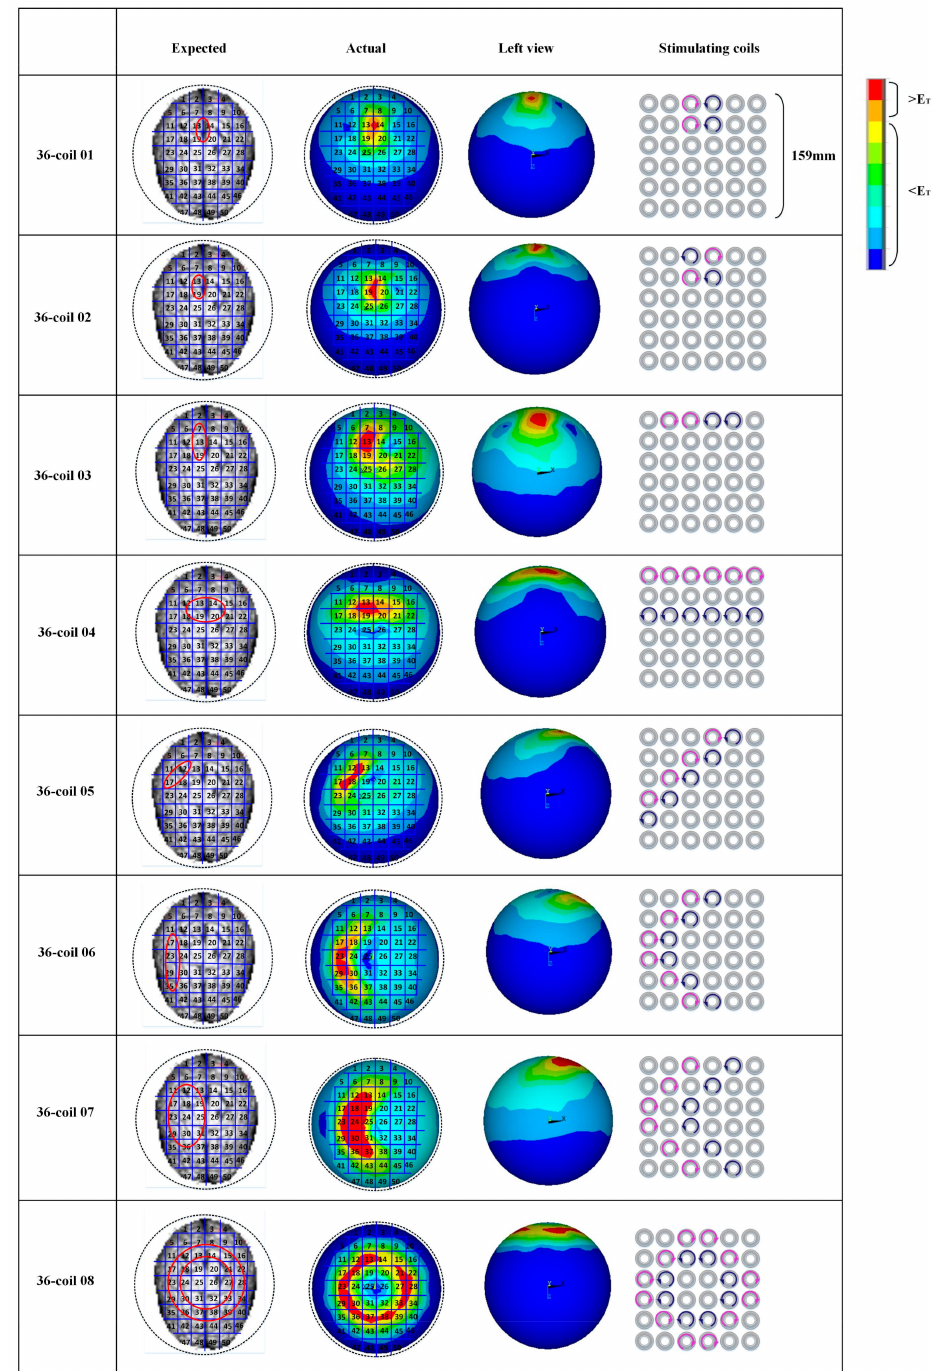
Figure 10. Stimulation results targeted at different cortical tissues. The units in red solid circles are interested regions. The activated parts and energized coils are shown correspondingly. Here, currents in coils are indicated by